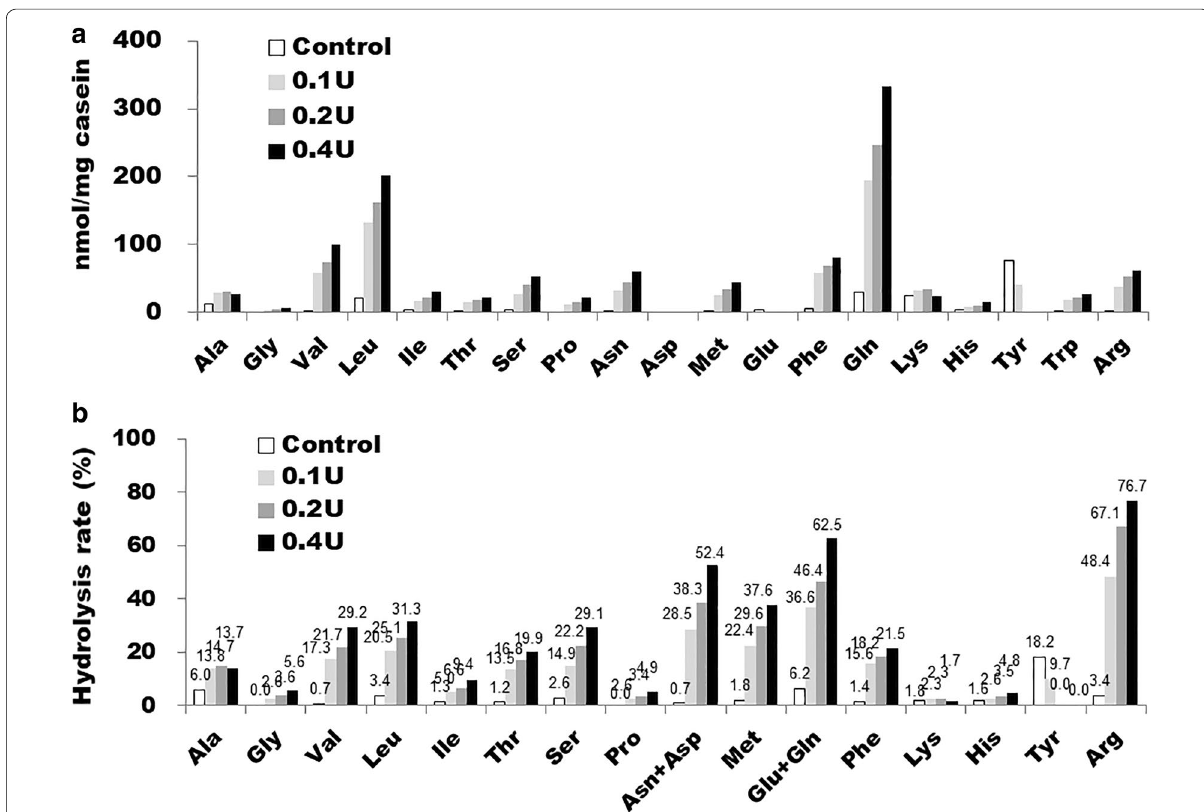
Fig. 3 a Free amino acid profiles of casein hydrolysates. The contents of 19 amino acids in the control (without XPO DUET treatment [white bar]) and after treatment with 0.1 U of XPO DUET (light gray bar), 0.2 U of XPO DUET (dark gray bar), and 0.4 U of XPO DUET (black bar). b Degree of hydrolysis (%) of casein hydrolysate in the control (without XPO DUET treatment [white bar]) and after treatment with 0.1 U of XPO DUET (light gray bar), 0.2 U of XPO DUET (dark gray bar), and 0.4 U of XPO DUET (black bar). The degree of hydrolysis is presented as the relative content of free amino acids present after treatment with 6 N HCl at 110 °C for 15 h